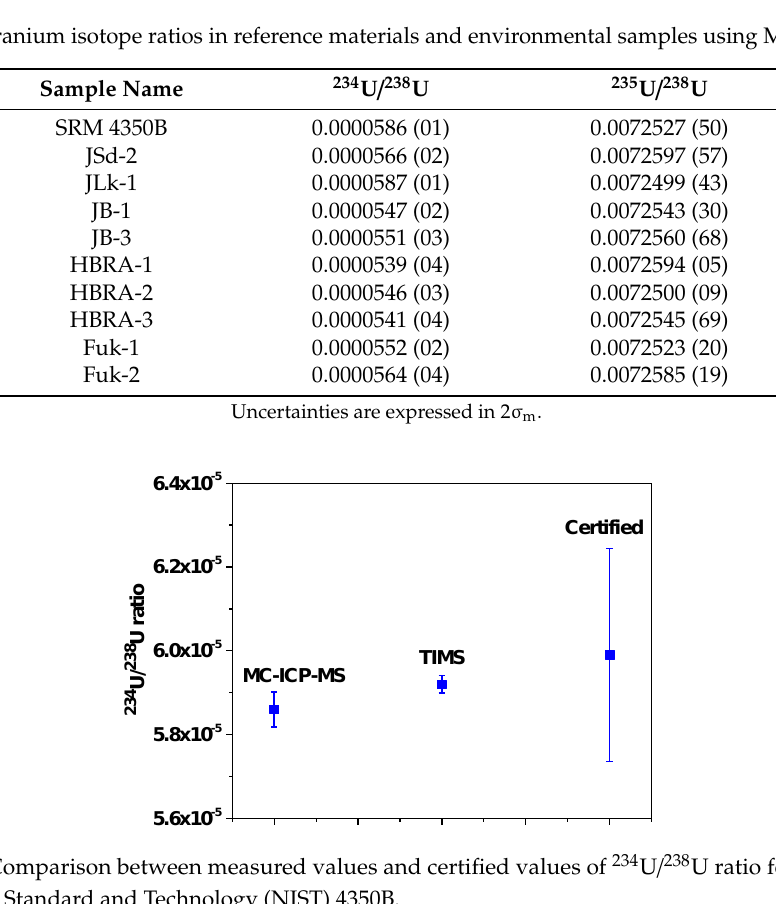
Table 5. Uranium isotope ratios in reference materials and environmental samples using MC-ICP- MS.